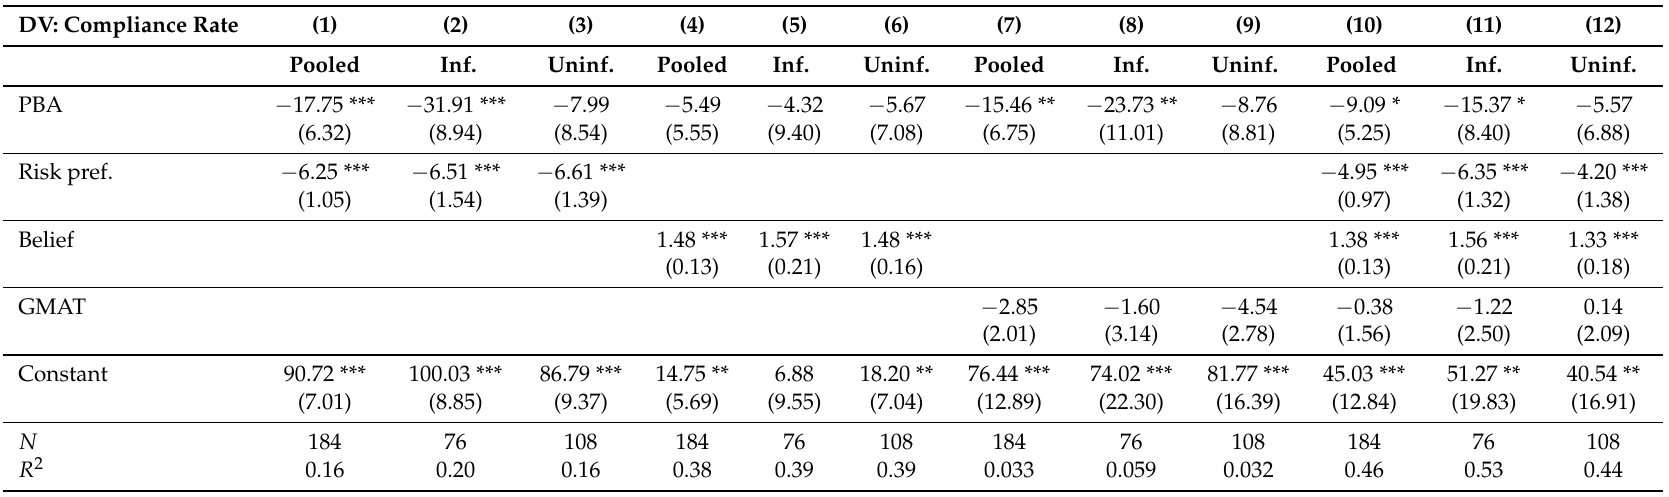
Table A14. Allocation treatment regressions (OLS) with covariates—excluding